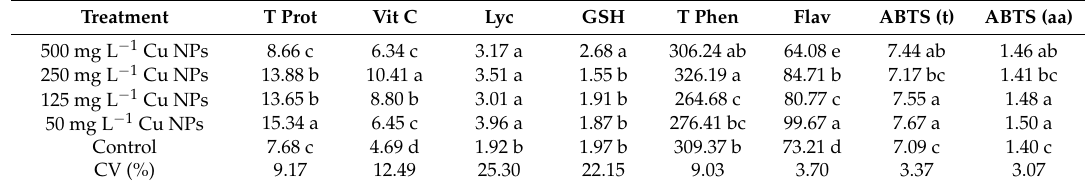
Each unit of data is the average of six replicates. CV: coefficient of variation. Different letters per column indicate significant differences between treatments according to the LSD Fisher test ( p ≤ 0.05). T Prot: total